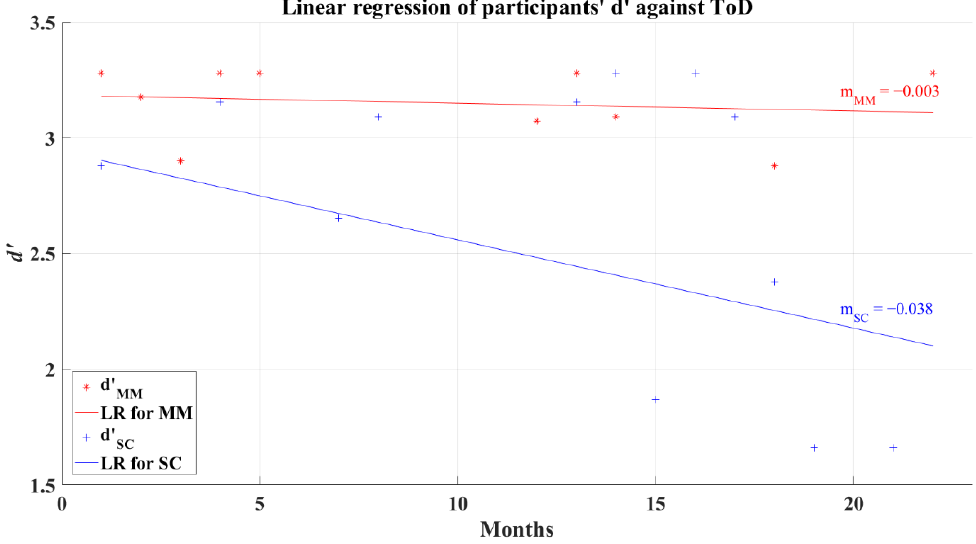
Figure 7. Linear regression for participants’ average d’ and elapsed time of diagnosis for 2AFC-P1. Red line—linear regression for Mild-Moderate post-COVID group (LR for MM); blue line—linear regression for Severe-Critical post-COVID group (LR for SC); 𝑑′ (cid:3014)(cid:3014) , Mild-Moderate group’s efficiency index; 𝑑′ (cid:3020)(cid:3004) , Severe-Critical group’s efficiency index; 𝑚 (cid:3014)(cid:3014) , Mild-Moderate group’s slope; 𝑚 (cid:3020)(cid:3004) , Severe-Critical group’s slope.